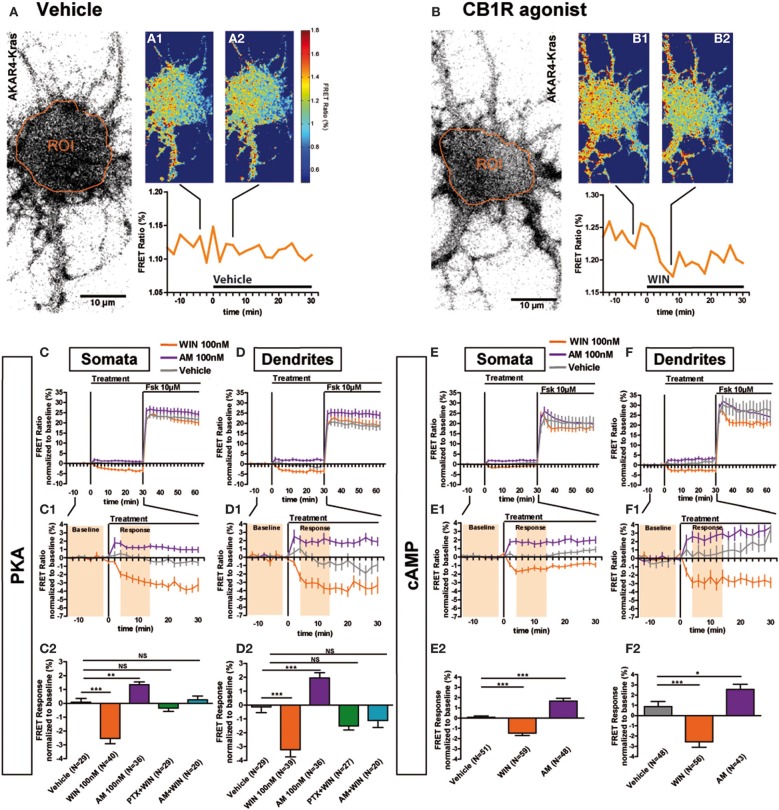
Somatodendritic CB1Rs constitutively inhibit the cAMP/PKA pathway. (A,B) Two representative neurons expressing the membrane-targeted PKA sensor AKAR4-Kras. The first image of the acquisition on YFP channel with the ROI is shown (A,B). The mean FRET ratio in somatic ROIs (orange) is shown at 4 min (-t4) before (A1, B1) and at 6 min (t6) after the addition of treatment at t0: Vehicle (A2) or agonist WIN55-212,2 (WIN) 100 nM (B2). (C–F) Averaged responses of AKAR4-Kras (C,D) or the cAMP sensor TEpacVV expressing neurons (E,F). The FRET ratio normalized to baseline was calculated for each neuron with a time-resolution of 2 min, separately in somata and dendrites. The curves represent mean ± S.E.M. of the FRET ratio for all imaged neurons at each time point. Addition of agonist WIN 100 nM but not of vehicle at t0 results in rapid FRET ratio decrease while inverse-agonist AM281 100 nM (AM) treatment results in increased PKA-activation. At 30 min, adenylyl-cyclase activator Forskolin (Fsk) was added at 10 μM, inducing a saturating increase of the FRET ratio. C1,D1,E1,F1: Zoom between -t14 and t30 of C,D,E,F, respectively, shows significant modulation of basal PKA activity after activation or blockade of CB1Rs. C2,D2,E2,F2: FRET responses were calculated as the mean response between t4 and t14 min (shaded zone labeled “Response” on C1,D1,E1,F1), using data normalized to the baseline (shaded zone between -t14 and -t2, labeled “Baseline” on C1,D1,E1,F1), as described in the Materials and Methods Section. Implication of Gi/o-proteins was shown by the specific inhibitor pertussis toxin (PTX), applied overnight at 100 ng/mL before the beginning of the experiment. The WIN effect was CB1R-induced as shown by pre-treatment with the CB1R-specific antagonist AM281 (1 μM 3 h before the beginning of the experiment). Data information: Data are expressed as mean ± S.E.M.; Statistical analysis was realized with one-way ANOVA followed by Newmann-Keuls post-test; NS p > 0.05, *p < 0.05, **p < 0.01, ***p < 0.001. Scale bar: 10 μm (A,B).